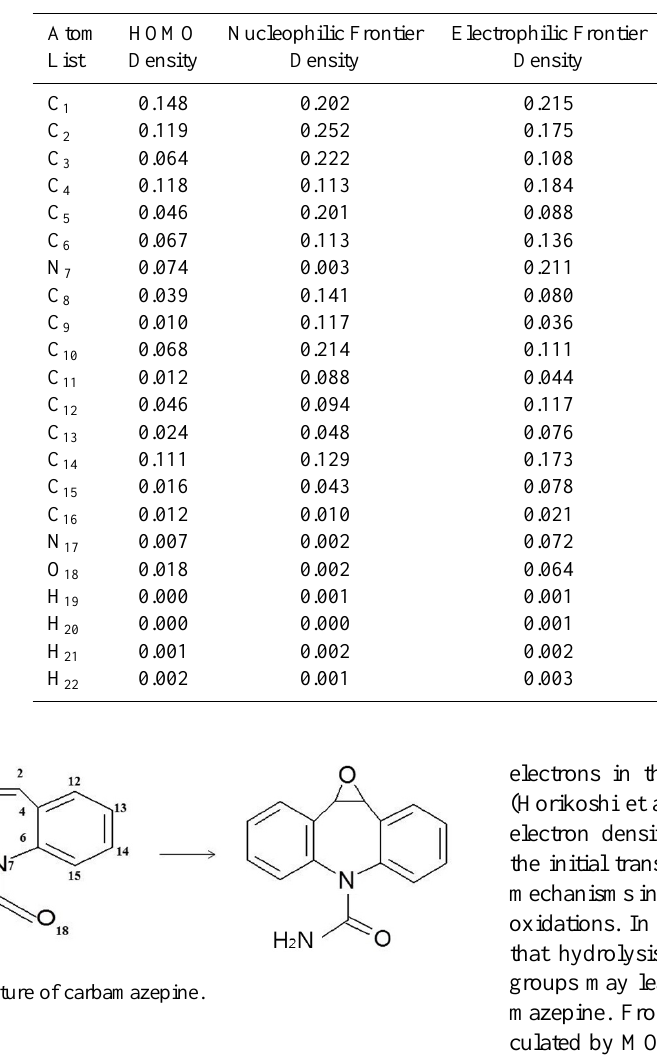
Table 5. Calculations of frontier electron density for carbamazepine.